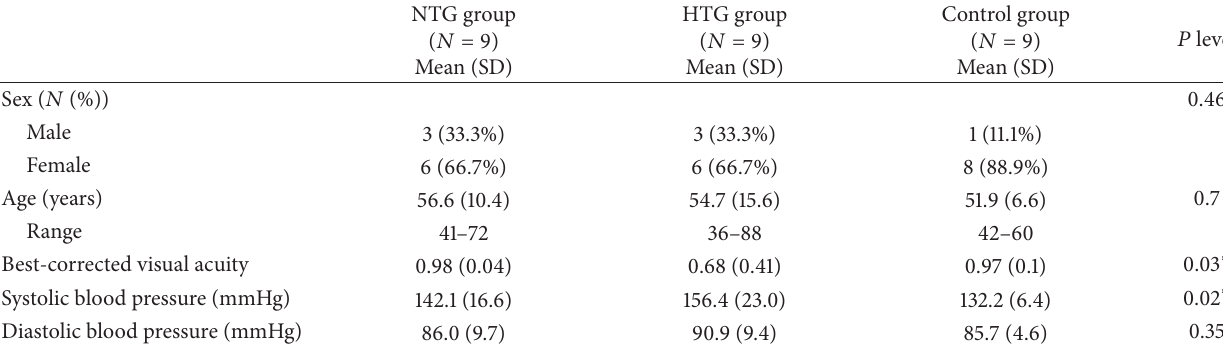
Table 1: Patients characteristics.